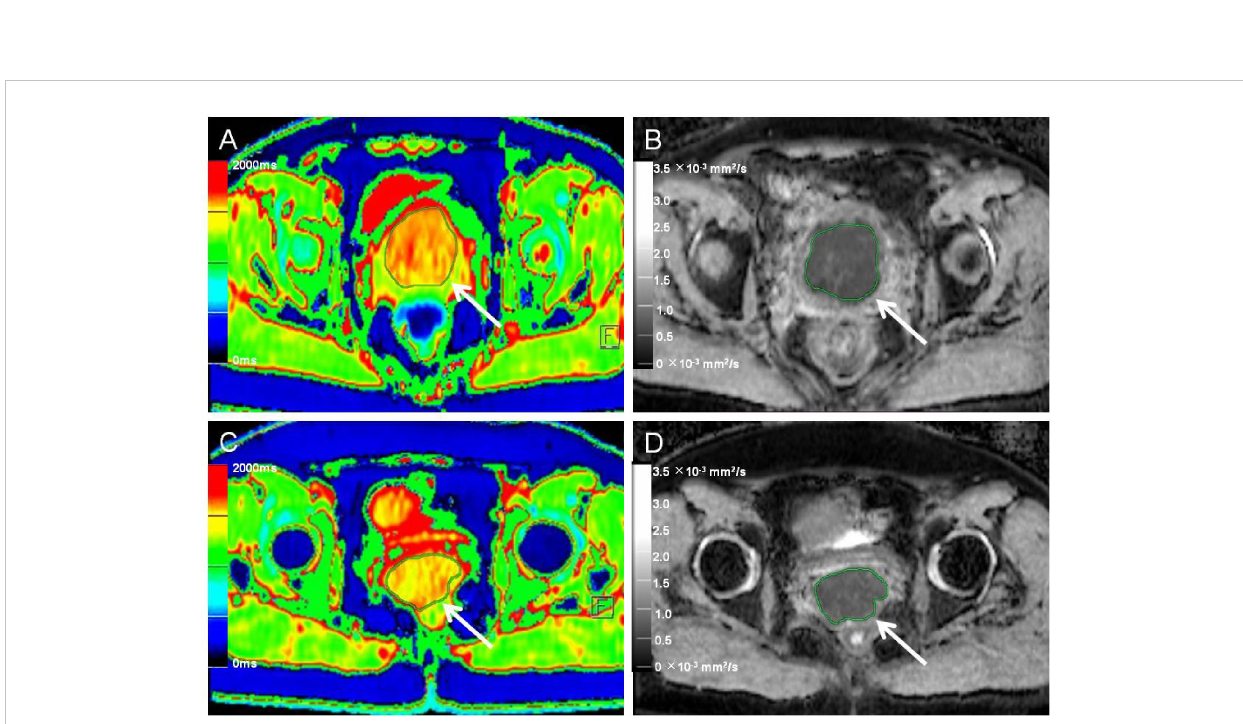
FIGURE 3 Native T1 mapping and apparent diffusion coef fi cient (ADC) images of recurrent and nonrecurrent cervical cancer (CC) in the non-surgical group. (A, B) A 55-year-old patient with recurrence during the follow-up period. (A) Axial T1 mapping pseudo-color map and (B) axial ADC image. The native T1 and ADC values were 1556.65 ms and 0.77 × 10 − 3 mm 2 /s, respectively. (C, D) A 51-year-old patient without recurrence during the follow- up period. (C) Axial T1 mapping pseudo-color map and (D) axial ADC image. The native T1 and ADC values were 1489.09 ms and 0.84 × 10 − 3 mm 2 / s, respectively. The white arrows in A – D indicate the locations of the